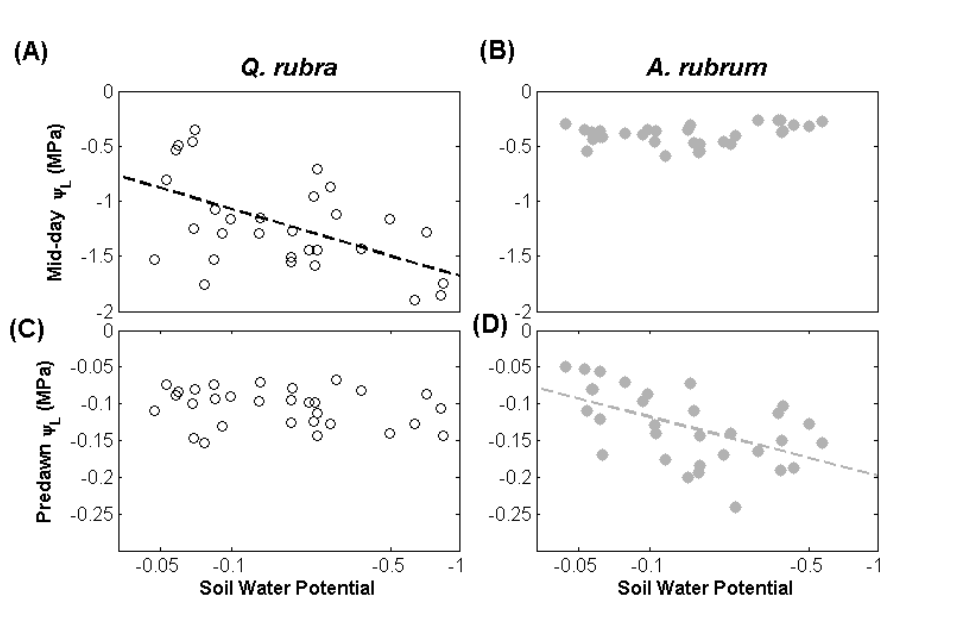
Figure 1. Responses of leaf water potential values (ψ ) to soil water potential at the top L 30 cm for 6 Q. rubra and 6 A. rubrum individuals. Significant regressions are shown in dashed lines. Soil water potential is in (MPa) and listed on reversed logarithmic scale with highly negative values (dry soil) on the right hand side of the scale. Mid-day leaf water potentials for: ( A ) Q. rubra ; and ( B ) A. rubrum . Predawn leaf water potentials for: ( C ) Q. rubra ; and ( D ) A. rubrum